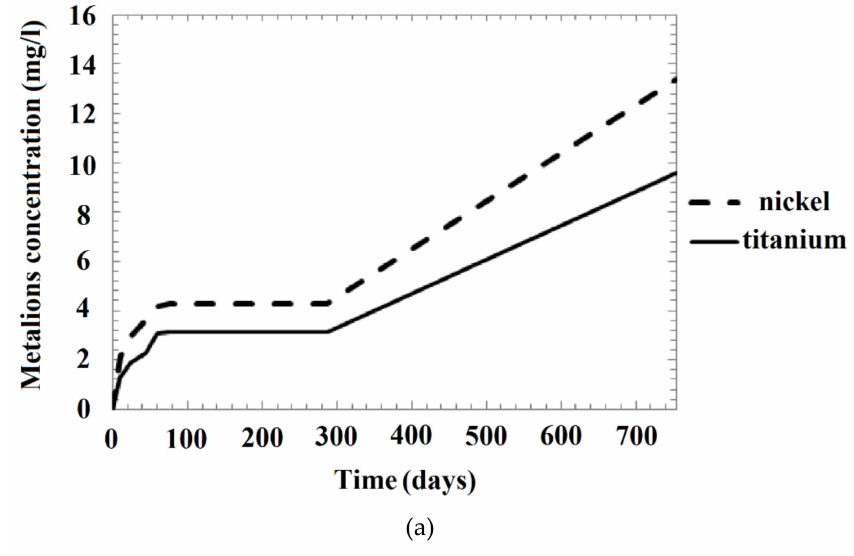
Figure 10. Change in the concentration of ions over time as each type of NiTi wire sample (Sample 1 – as-received, Sample 2 – annealed at 450 ◦ C for 15 min, Sample 3 – mechanically treated in the direction of the long axis of the samples using diamond paste (3 µ m followed by 1 µ m), and Sample 4 – mechanically treated and annealed) was immersed in a bu ff er solution at pH 1.68 (Solution 1, Table 1): ( A,C ) nickel and ( B,D )